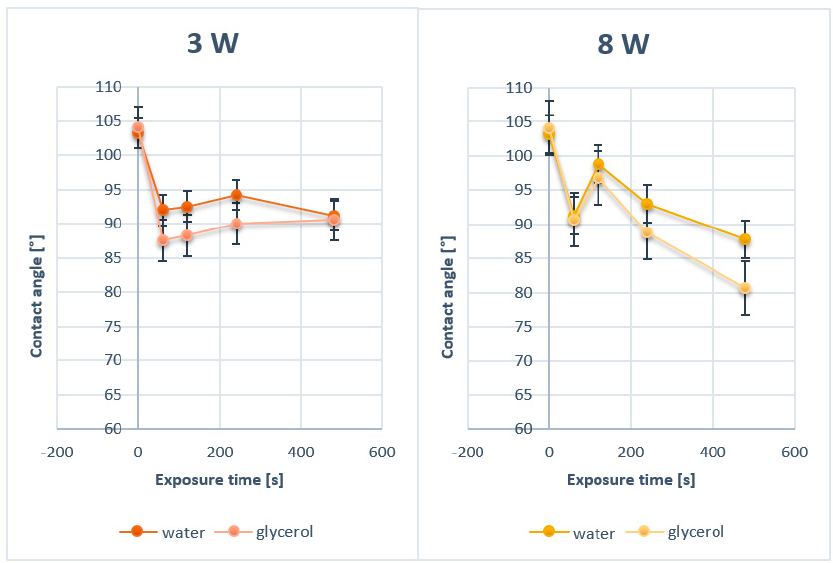
Figure 1. Contact angles of pristine polytetrafluoroethylene (PTFE) and PTFE modified by plasma at 3 and 8 W for 60, 120, 240, and 480 s.